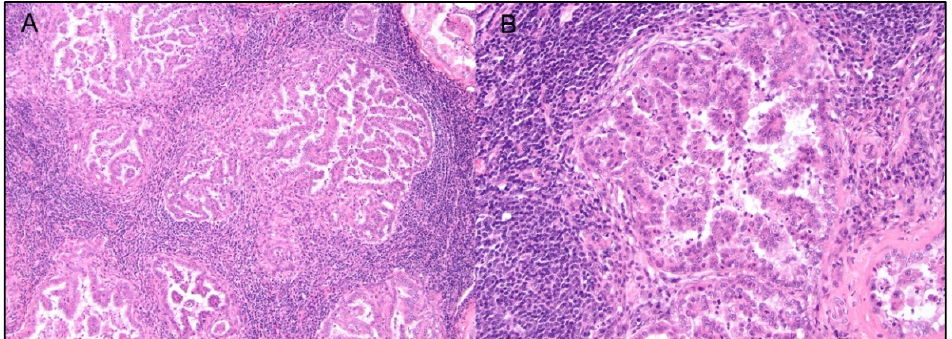
Figure 7. Canine pulmonary carcinoma (with metastasis to right bronchial lymph node) classified as grade III, hematoxylin, and eosin. ( A ) High-grade TILs: numerous lymphocytes are distributed adjacent to the cancer nests, 10×. ( B ) Higher magnification, 20×.